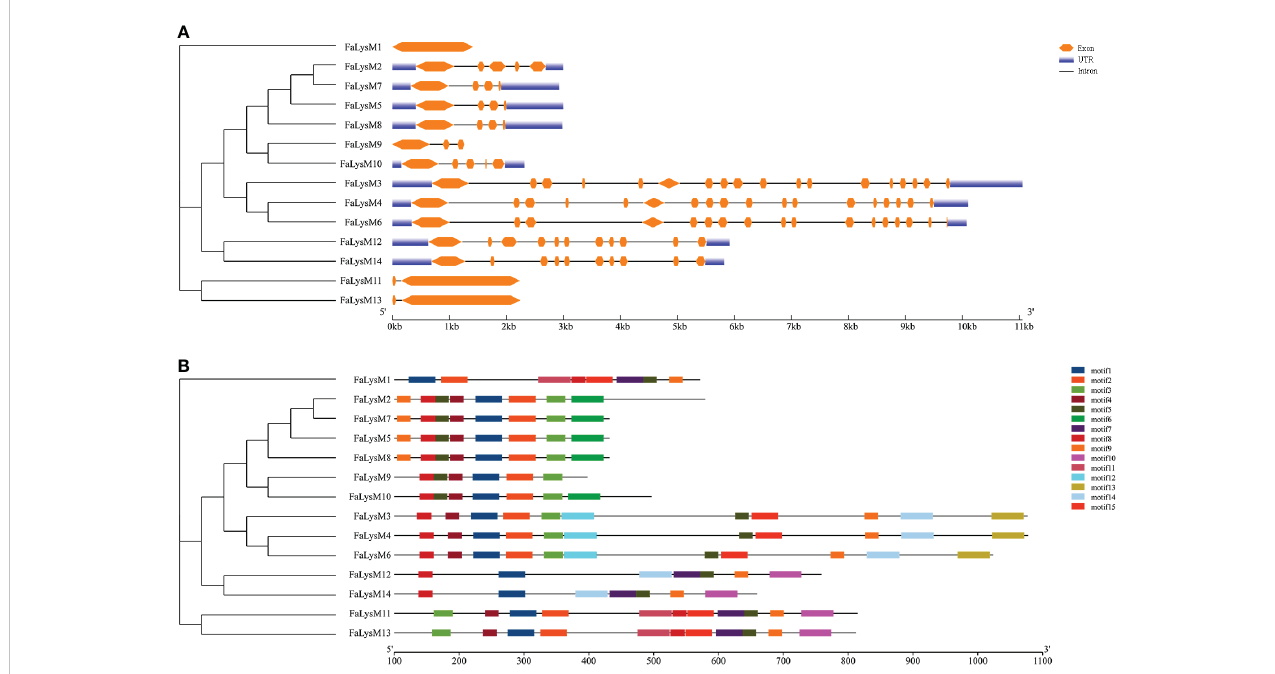
FIGURE 3 The conserved motifs and exon-intron structure of LysM genes in octoploid strawberry. (A) Gene structure of FaLysM genes . Exons and introns were represented by orange boxes and black lines, respectively. And the genomic length is indicated at the bottom. (B) Motif composition of FaLysM genes . Different colored boxes indicate motifs 1-15, and the information for each motif is in Supplementary Table S5. The scale of the length of proteins is at the